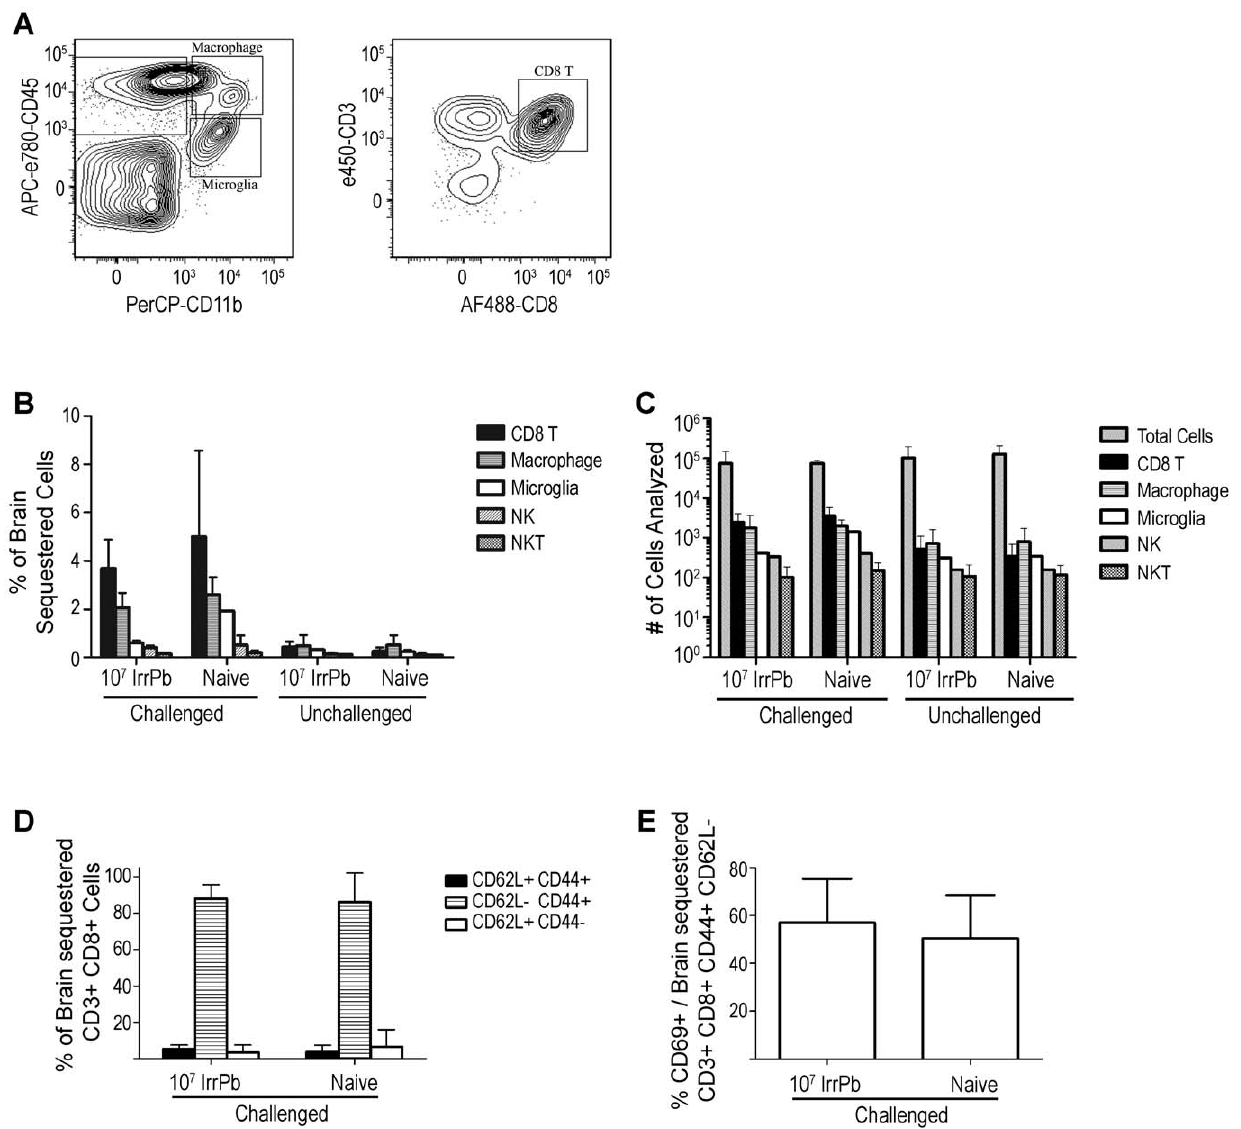
Figure 6. Flow cytometry analysis of cell subtypes in brains of mice immunized with 10 7 IrrPb. Brain samples were processed on day 6 after virulent challenge and were pooled from all 4 mice in each group. Results are combined from two independent experiments. A ) Representative cell plots from naı¨ve mouse brain samples during a virulent infection. Gates for macrophages (CD45 + , CD11b + ), microglia (CD45int, CD11b + ), and CD8 T cells (CD45 + , CD3 + , CD8 + ) are indicated. B ) Graph of brain sequestered cell frequencies. Naı¨ve mice had increased frequencies of brain- sequestered CD8 T cells and macrophages during a virulent challenge (Naı¨ve Challenged, black and hatched bars). Immunized challenged mice displayed frequencies of brain-sequestered CD8 T cells and macrophages that were similar to frequencies observed in naı¨ve mice during a challenge (10 7 IrrPb Challenged, black and hatched bars). The mean difference in brain-sequestered CD8 T cells from 10 7 IrrPb challenged vs. naı¨ve challenged mice was 2 .9 ( 2 2.8, 1.0)%, p=.12, Two Way ANOVA. C ) Graph of the number of cells analyzed for each group. The absolute numbers of total cells and CD8 T cells analyzed were not significantly different between the 10 7 IrrPb immunized and naı¨ve groups, p . .5, Two Way ANOVA. D ) Brain- sequestered CD8 T cells from both immunized and naı¨ve mice largely had a CD44 + CD62L 2 effector phenotype (hatched bars), and E ) approximately 55% of these effector cells were also CD69 + in both Naı¨ve mice and 10 7 IrrPb immunized mice after challenge.